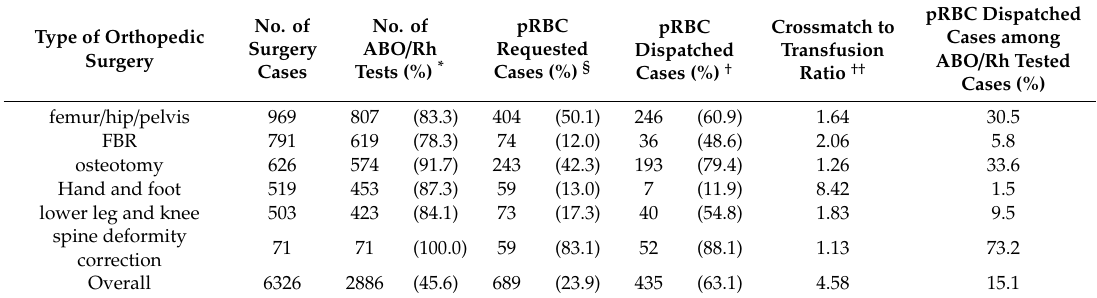
Table 3. Frequency of ABO / Rh type and screening and transfusion in orthopedic surgery. Type of Orthopedic